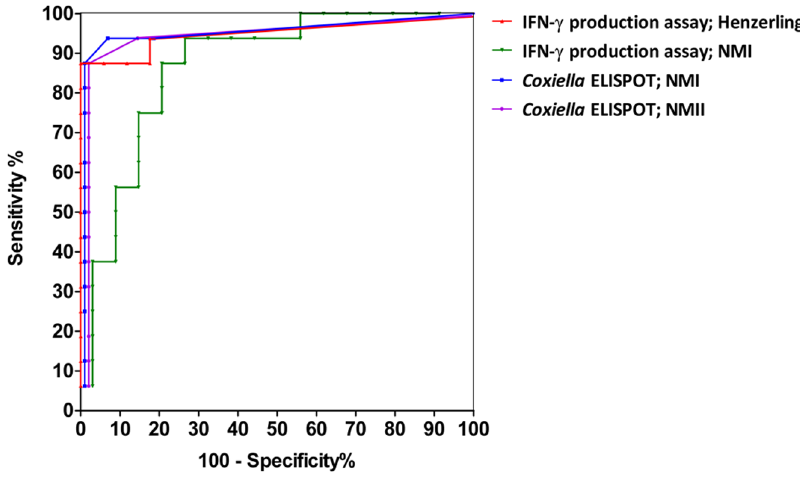
Figure 2. ROC curves of the IFN- c production assay and the Coxiella ELISPOT. ROC curves are shown for each assay with each stimulating antigen separately. Abbreviations: NMI, Nine Mile phase 1; NMII, Nine Mile phase 2; IFN- c ,